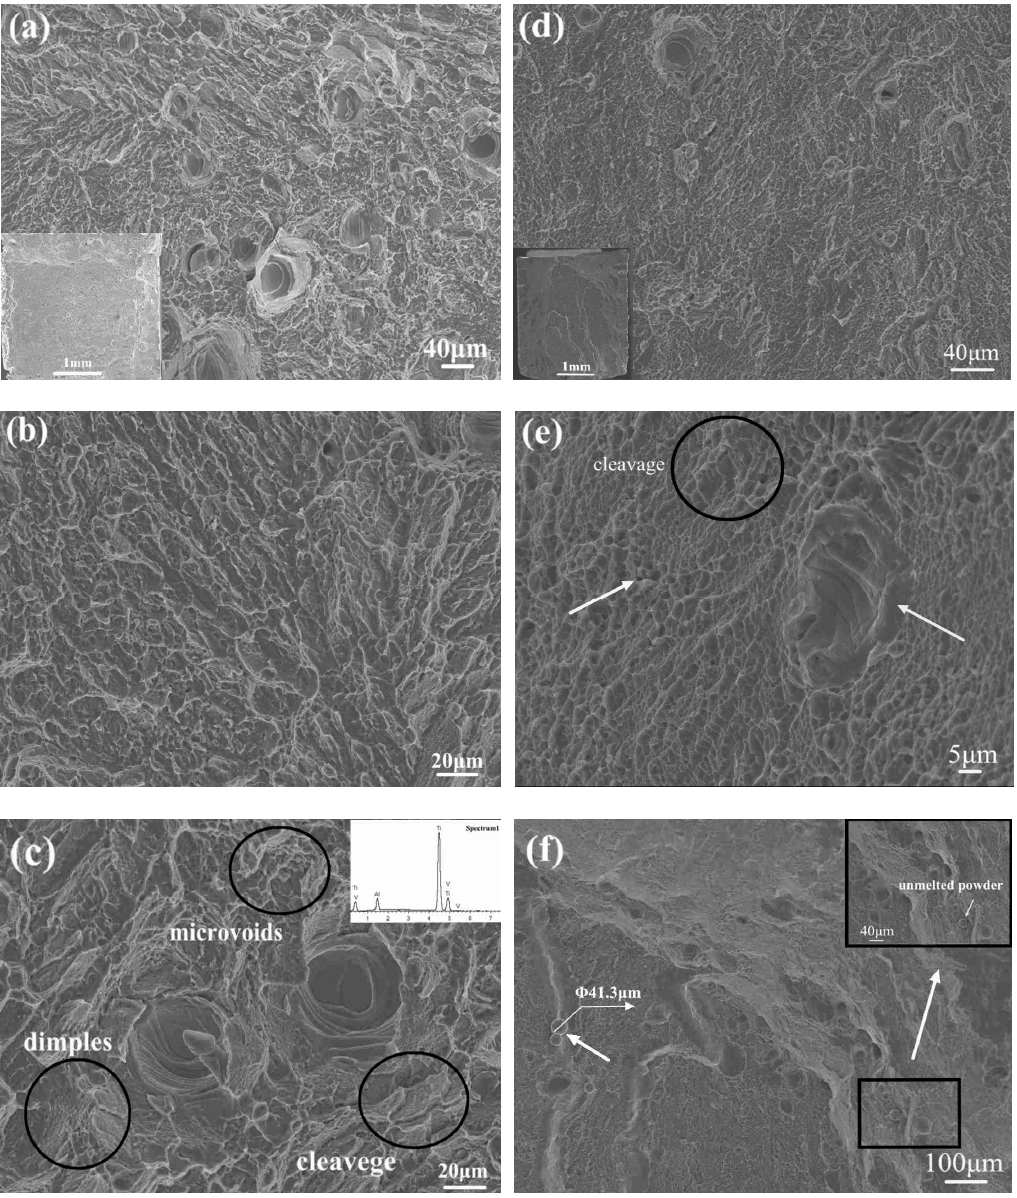
Figure 8. Ti6Al4V fracture surface of the tensile specimens (edge orientation): as ‐ built parts ( a – c ), stress ‐ relieved parts ( d – f ).